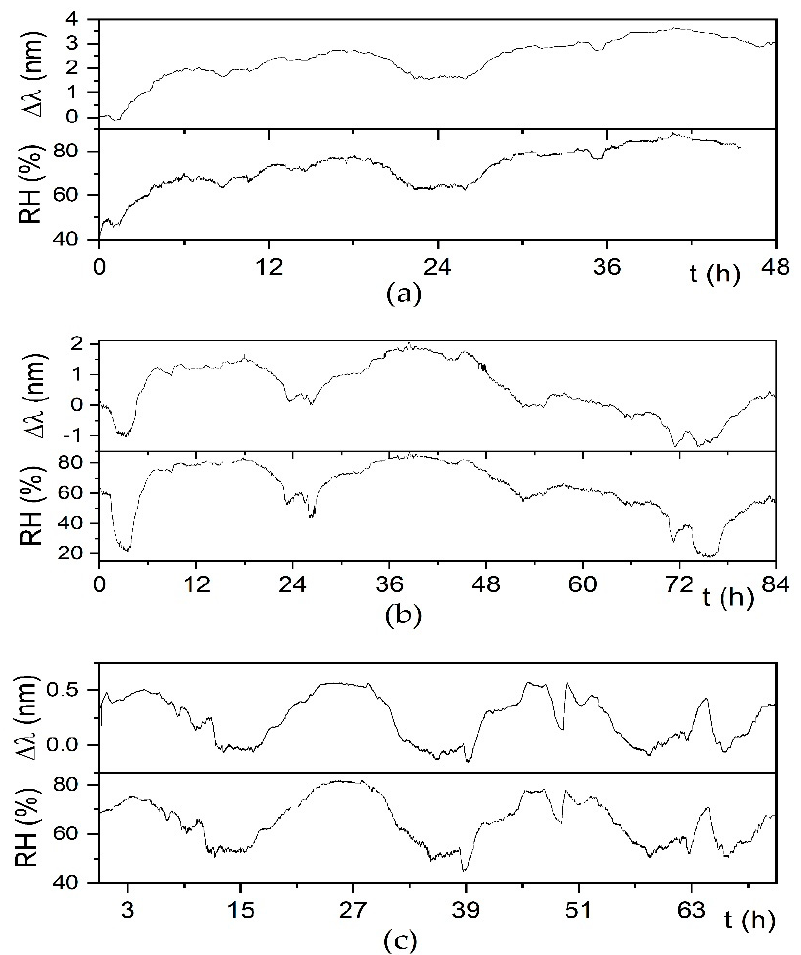
Figure 10. Response of sample FBG-FP in different periods of the year: ( a ) for two days in December; ( b ) for three days in February; ( c ) for three days in May. RH value was measured by the reference thermo-hygrometer.